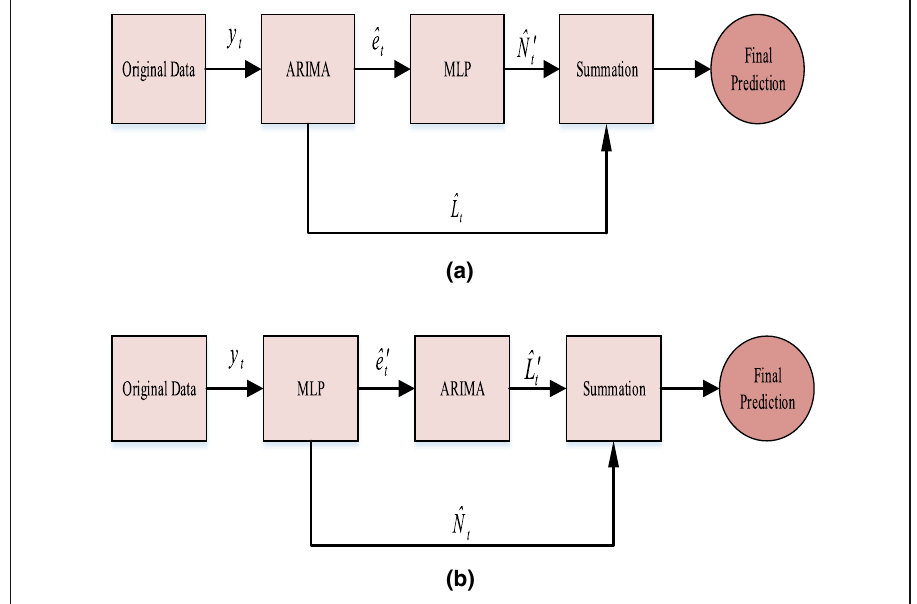
Fig. 2 Framework of ( a ) ARIMA-MLP and ( b ) MLP-ARIMA